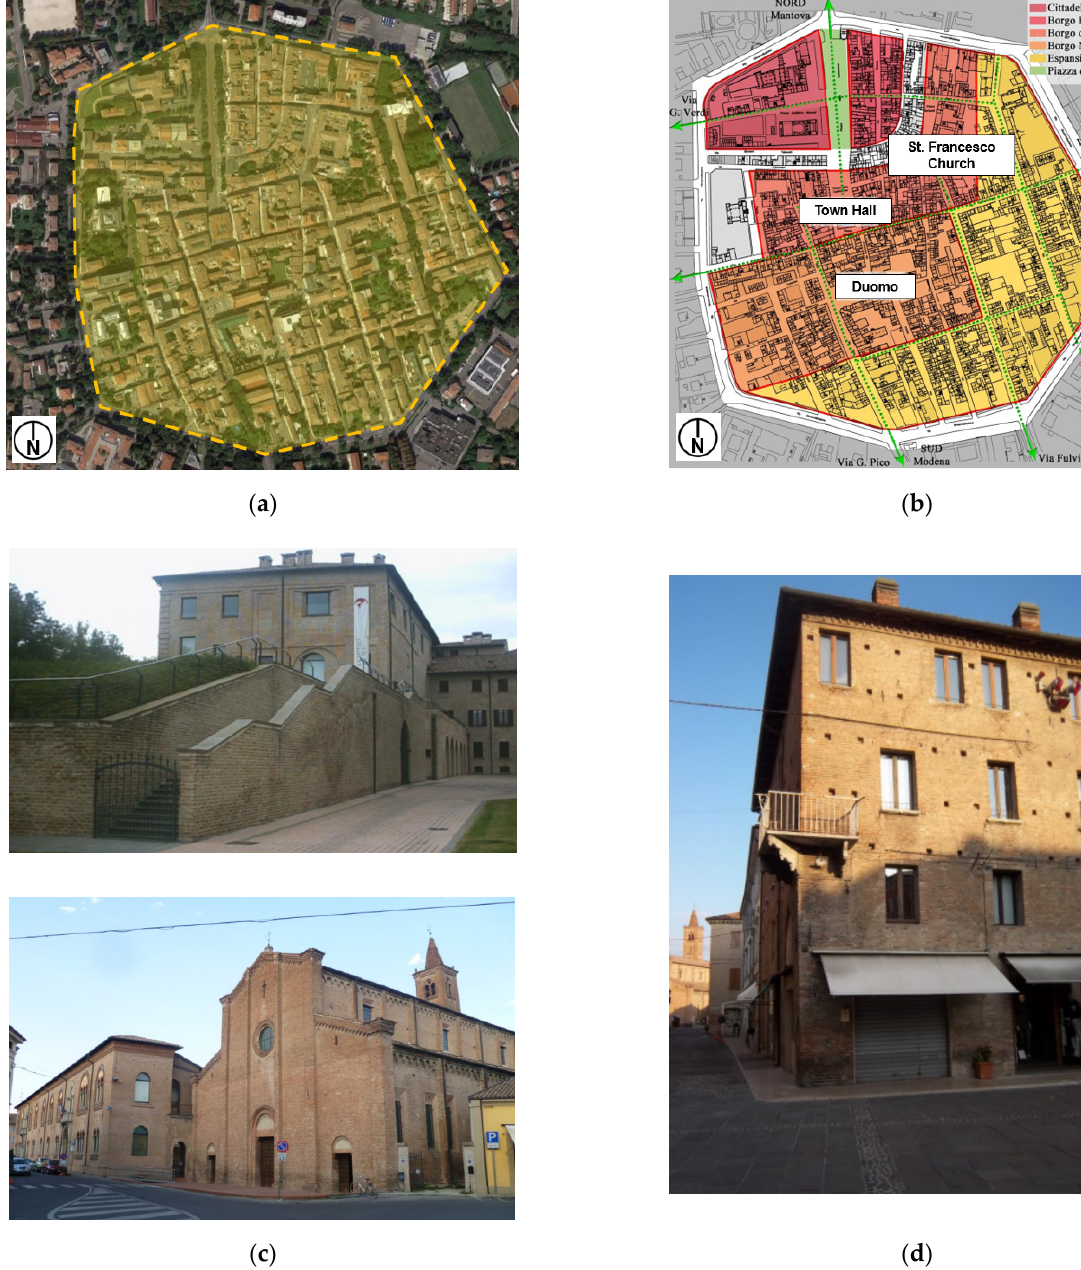
Figure 2. Historical compartment and urban plan of the city with the main roads and sub-urban borough ( a , b ) [26]; ( c , d ) styles of architectural buildings.